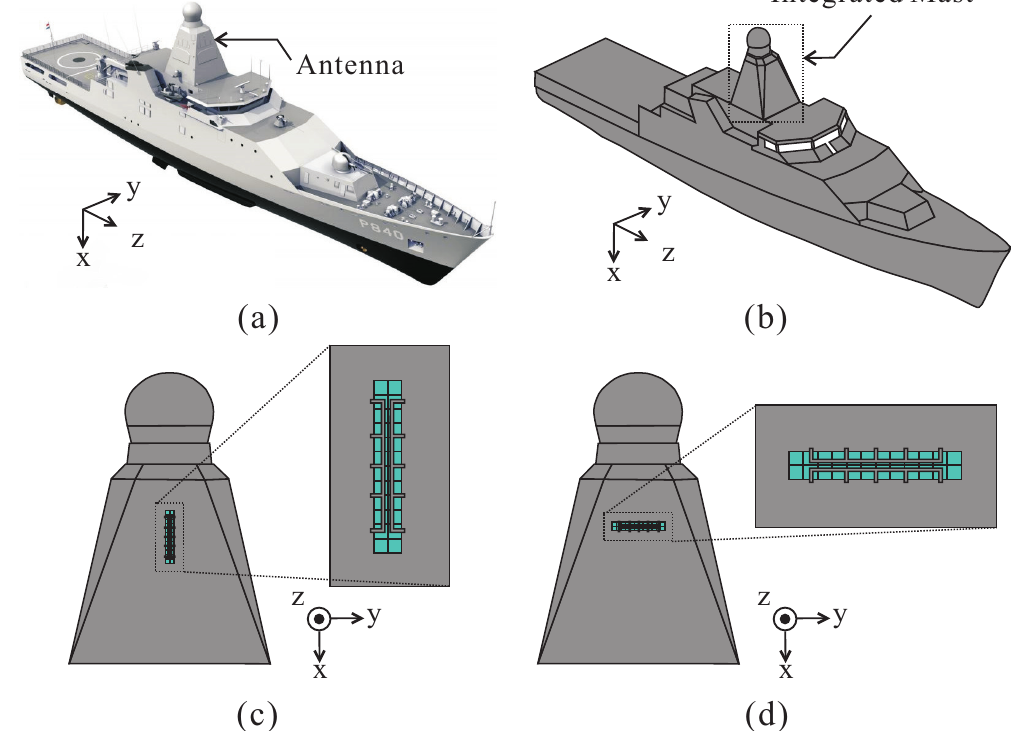
Figure 8. Proposed antenna mounted on the integrated mast of an offshore patrol vessel (OPV): ( a ) Photograph of a Holland-class OPV. ( b ) 3-D modeling of an OPV with the integrated mast. The proposed antenna mounted on the integrated mast of the OPV on the ( c ) x -axis and ( d ) y